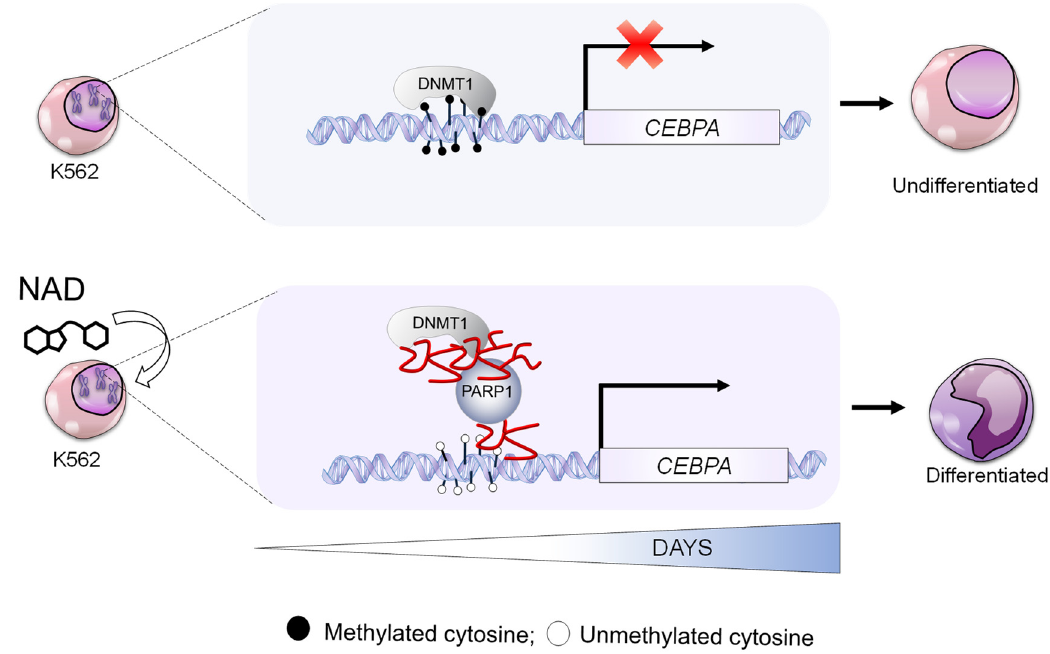
Figure 6. Model showing the molecular mechanism of CEBPA gene reactivation by NAD . CEBPA is epigenetically silenced in K562. DNMT1 ensure a constant methylated status of CEBPA promoter (upper panel). The NAD supplementation to K562 cell culture, boosts PARP1 to produce ADP-ribose polymers leading to DNMT1 inhibition (bottom panel). The ultimate effect is reactivated transcription of CEPBA .